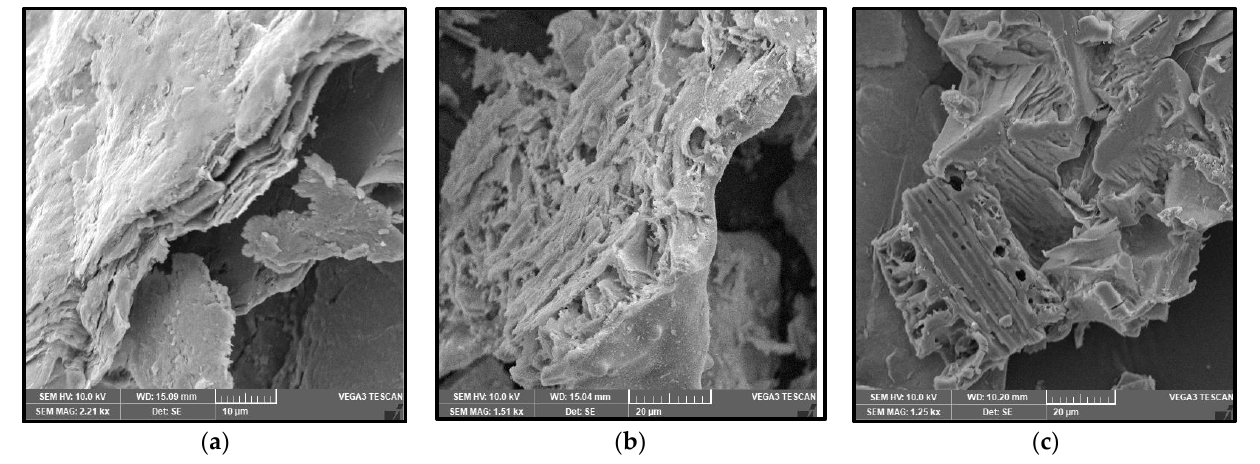
Figure 1. ( a ) Multilayer structure of MXene; ( b ) porous structure of RHA; ( c ) hybrid R-MX composites under SEM characterisation.